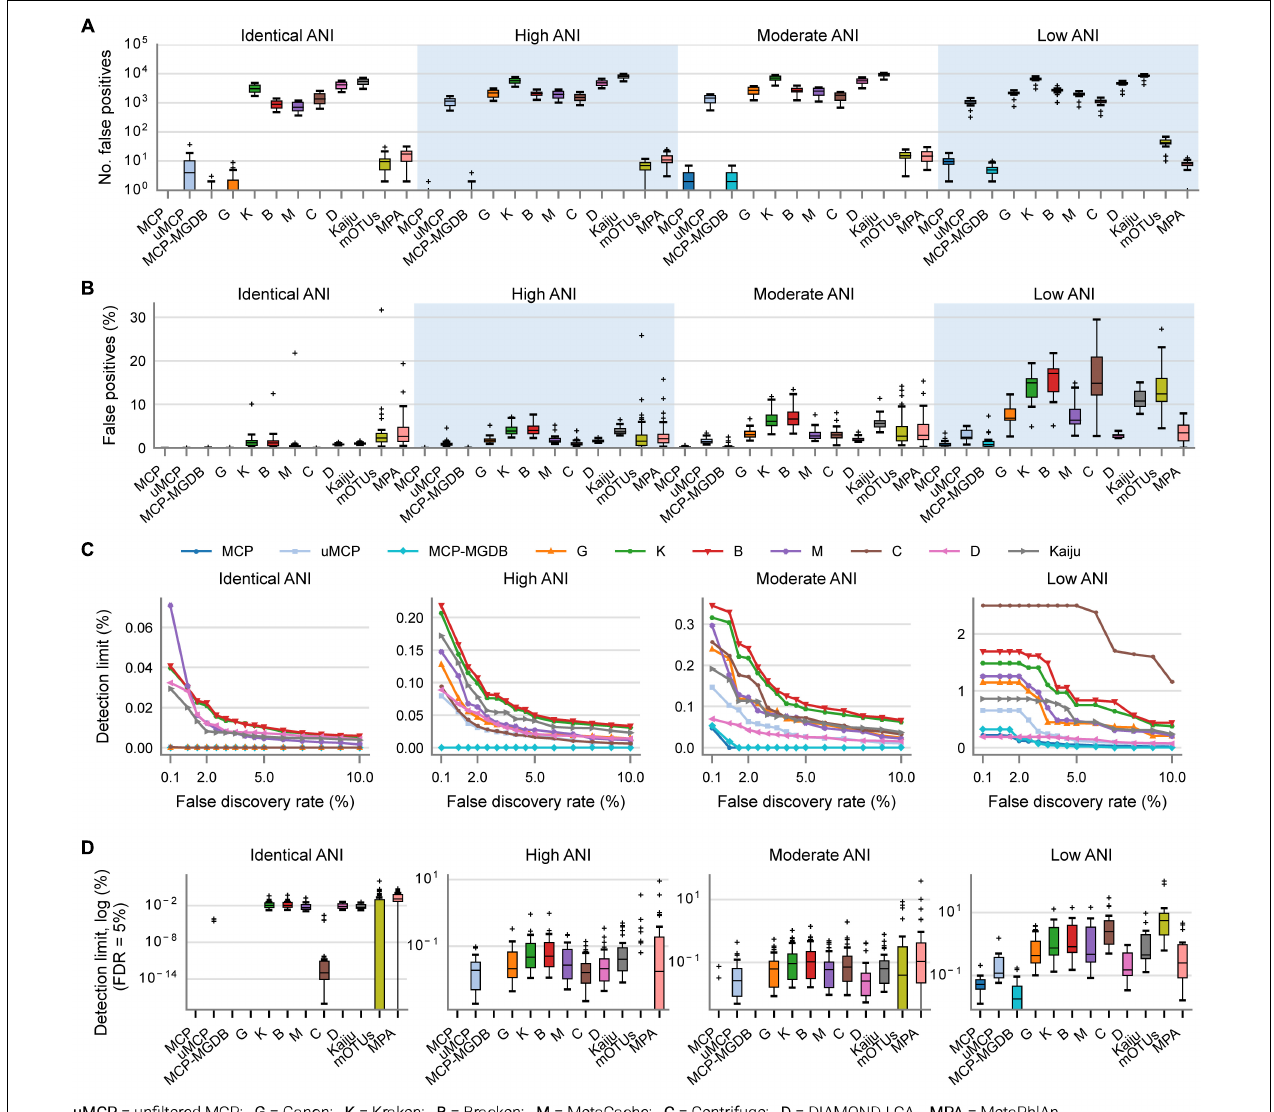
FIGURE 1 | Metagenomic classifiers have different minimum species abundance limits at which species can be reliably detected. (A) Number of false positive species predictions made by each classifier on mock communities with decreasing ANI similarity to reference database genomes. (B) Percentage of predicted community profiles comprised of false positive predictions. The relatively low community percentages indicate that the majority of false positive predictions are low abundance species. With the exception of the MCP, mOTUs, and MetaPhlAn, these results illustrate that low abundance species must be filtered from the profiles predicted by metagenomic classifiers in order to reduce false positive predictions. (C) Median detection limit of each classifier over all mock communities at a given level of ANI similarity to the reference database for varying FDRs. MCP, uMCP, and Ganon report zero false positives for mock communities comprised of genomes in the reference database (identical ANI) and consequently have a median detection limit reported as 0% indicating that all species could be identified without any false positives. Centrifuge and MCP-MGDB only report extremely low abundance false positives for the identical ANI mock communities resulting in median detection limits of 0.00036 and 0%, respectively. Results for mOTUs and MetaPhlAn are not shown as they have substantially higher detection limits than the other classifiers ( Supplementary Figure 1 and Table 3 ). (D) Detection limit of each classifier on each mock community resulting in an FDR of 5%. MCP, MCP-MGDB, and Ganon have detection level at or near 0% across all samples at a number of ANI levels so do not produce visible box-and-whisker plots (see Table 3 ). The box-and-whisker plots show the lower and upper quartiles as a box, the median value as a line within the box, 1.5X the interquartile range as whiskers, and outliers as crosses.